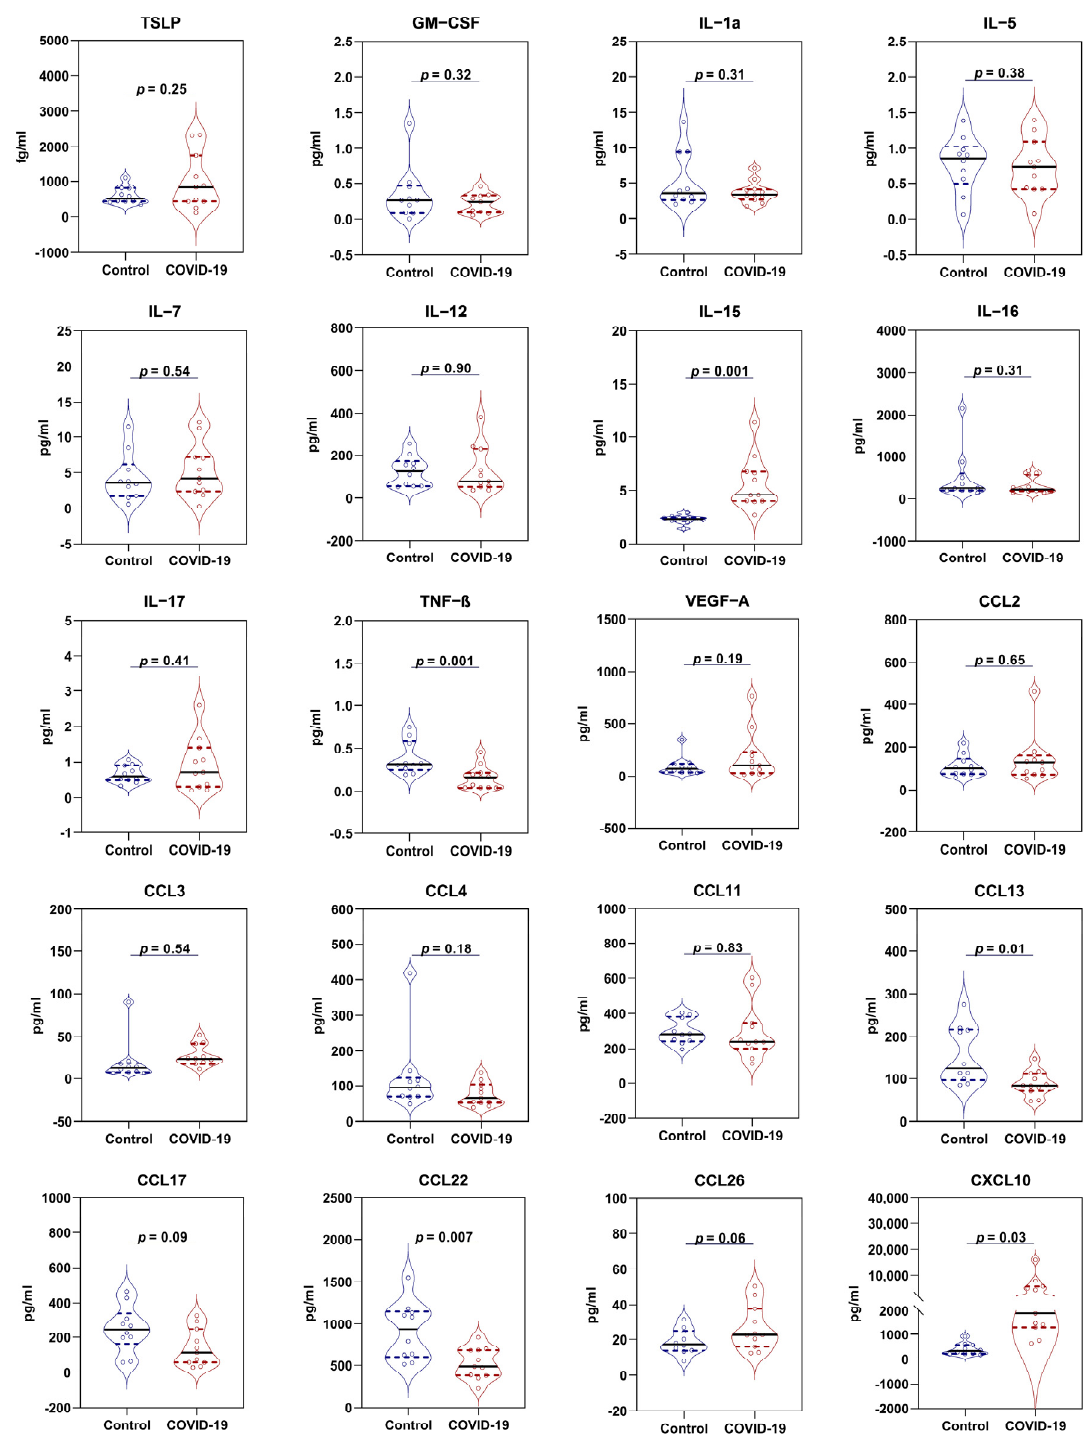
Figure 1. Cytokine profile of study participants. Data presented as mean (solid line, standard error of mean (SEM)), unless otherwise specified. Quartile values presented by dashed lines. p values were obtained from one-way analysis of covariance (ANCOVA) adjusted for age and sex. Note that there are missing values (2 measurements) for GM-CSF in the COVID-19 group. For abbreviations, see text.